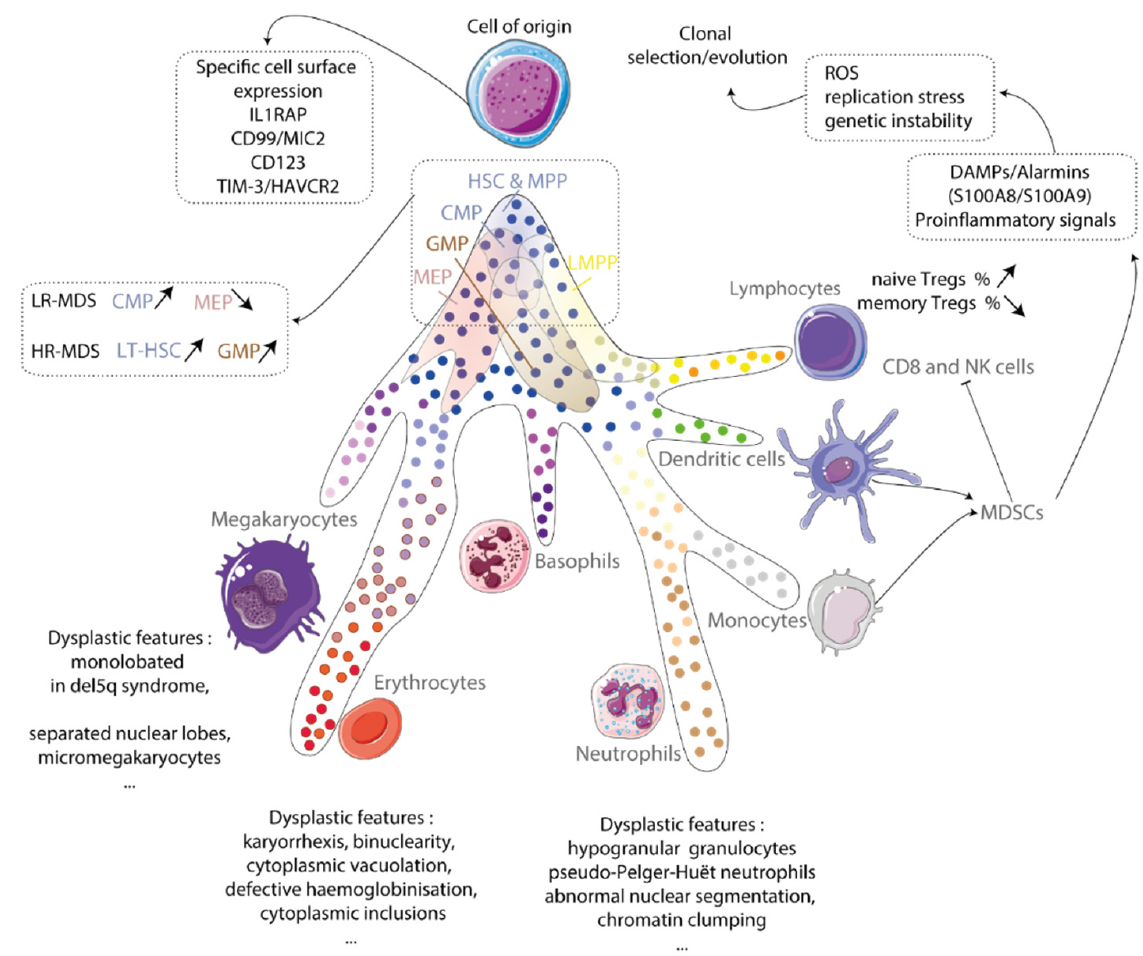
Figure 1. Cell of origin. Myelodysplastic syndrome originates from a clonal hematopoietic stem cell. This cell expresses specific surface markers and drives a myeloid-biased hematopoiesis at the expense of the lymphoid lineage. Hematopoietic stem and progenitor compartments are disturbed and produce dysplastic megakaryocytes, erythroblasts and granulocytes. Inflammatory microenvironment mainly myeloid-derived suppressive cells (MDSCs) producing alarms contribute to ROS generation, replication stress and genetic instability that forces the clonal evolution. IL1RAP: IL-1 receptor accessory protein; TIM-3/HAVCR2: T-cell immunoglobulin mucin-3/Hepatitis A virus cellular receptor 2; LR-MDS: low-risk MDS; HR-MDS: high-risk MDS; HSC: hematopoietic stem cell; LT-HSC: long-term hematopoietic stem cell; MPP: multipotent progenitors; CMP: common myeloid progenitor; GMP: granulocytic myeloid progenitor; MEP: megakaryocytic-erythroid progenitor; Treg: regulator T cells; NK: natural killer; ROS: reactive oxygen species; DAMPs: damage-associated molecular patterns.